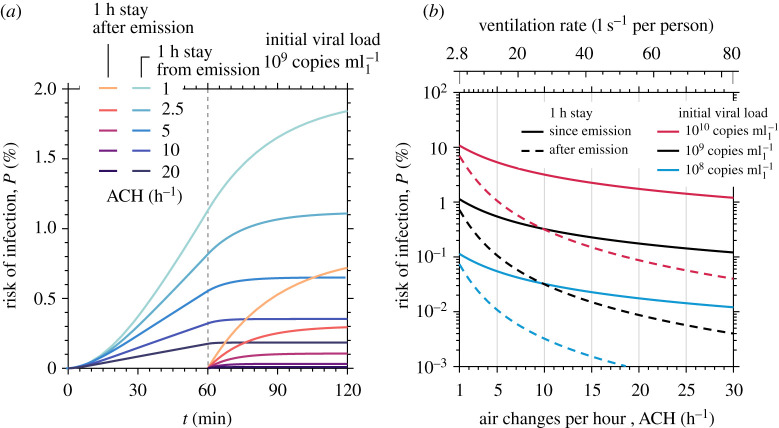
Infection risk in terms of (a) exposure time and (b) ventilation rate in a 200 m3 room with one infected occupant. (Online version in colour.)